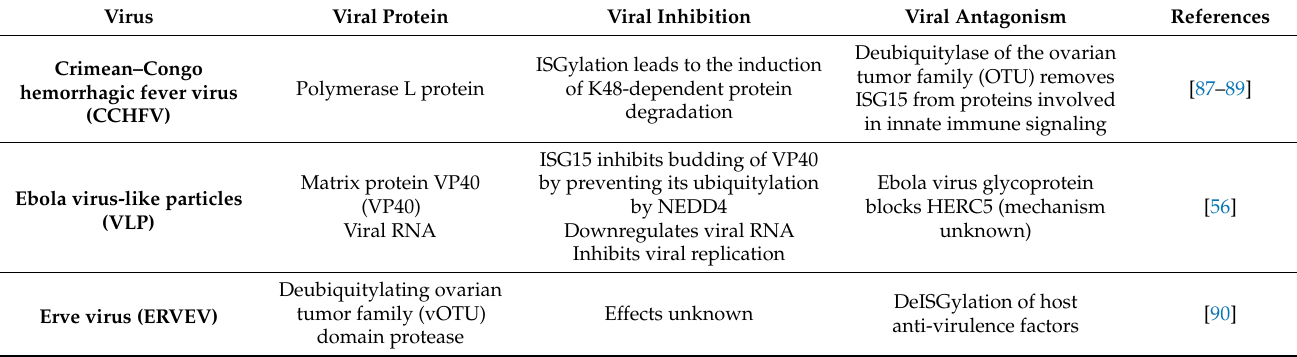
Table 1. HERC5-dependent ISGylation of viral proteins and their downstream